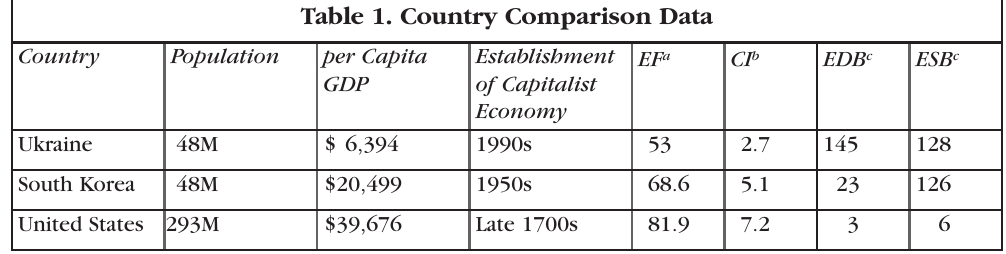
Table 1. Country Comparison